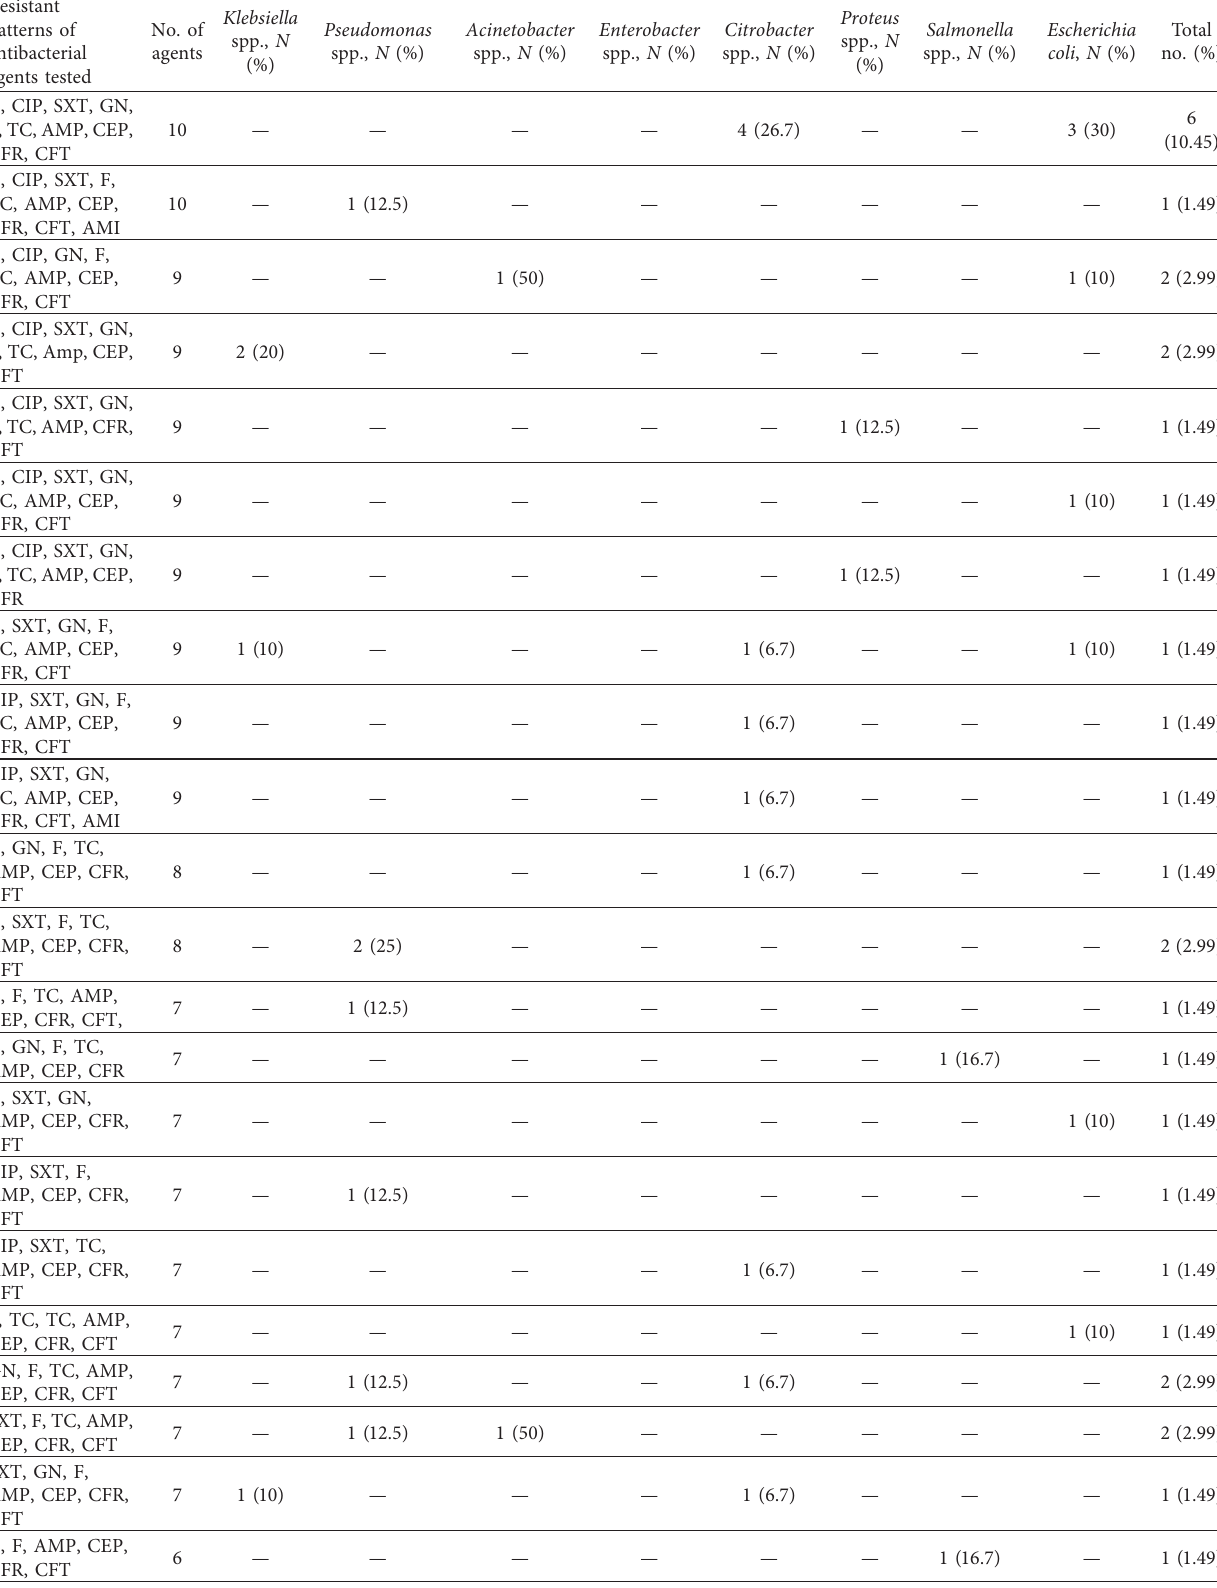
Table 4: Multidrug resistance patterns of Gram-negative isolates among patients in surgical wards at the Halibet and the Orotta National Referral Hospital in Asmara, Eritrea,